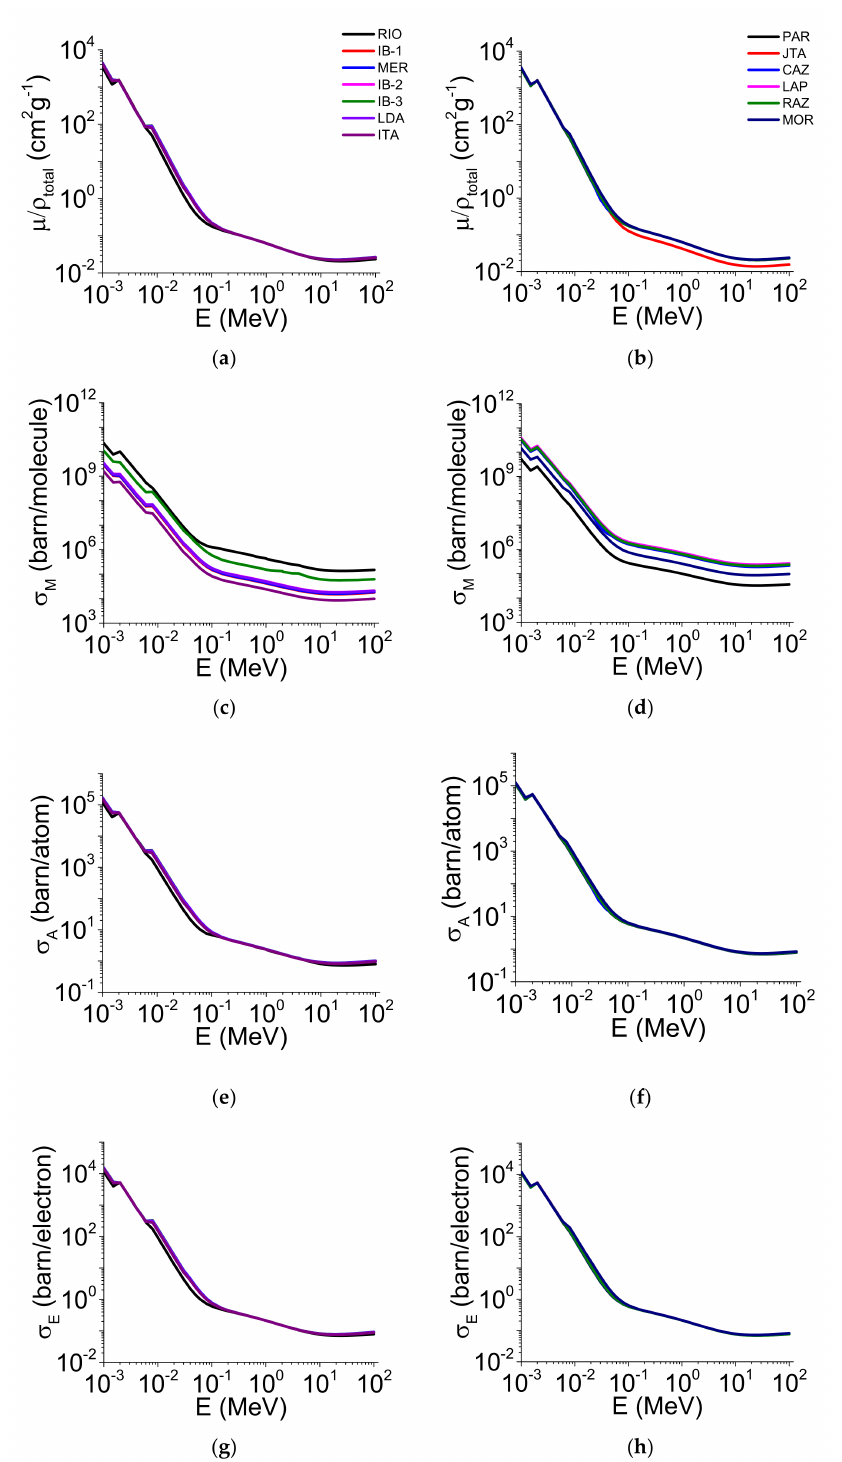
Figure 4. Mass attenuation coefficient ( µ / ρ ), molecular cross-section ( σ M ), atomic cross-section ( σ A ), and electronic cross-section ( σ E ) variation as a function of the photon energy (E) (1 keV–100 MeV) for the <45 µ m aggregate sizes in the clayey soils ( a , c , e , g ) and the loamy/sandy soils ( b , d , f , h